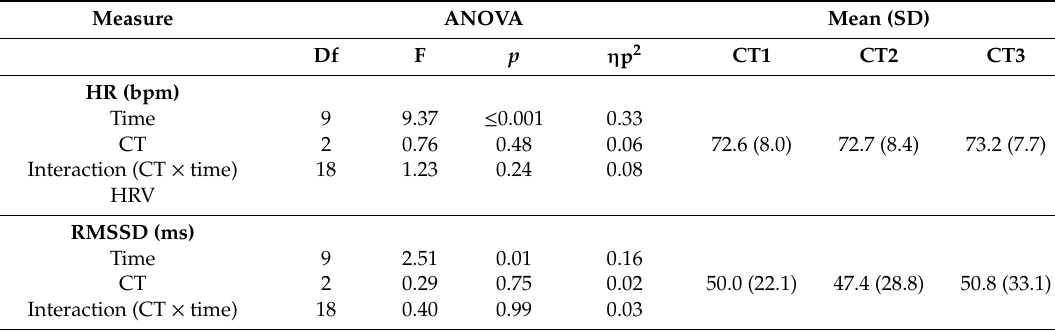
Table 2. Physiological indicators of stress (heart rate, heart rate variability (HRV), blood pressure (BP), salivary alpha amylase (sAA)), and cortisol during work. Results of repeated measures ANOVAs with main e ff ect and interactions, and mean values in each CT condition across all points in